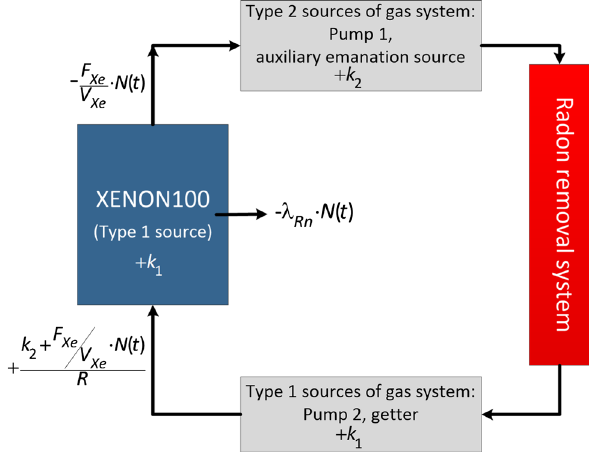
Fig. 2 Diagramofthedifferentradonsourcescontributingtotheradon activity in the detector: the experimental setup can be divided into the XENON100 detector, the radon removal system and the gas system before/behind the radon removal system, respectively. Depending on its position in the system, a radon source is referred to as type 1 or type